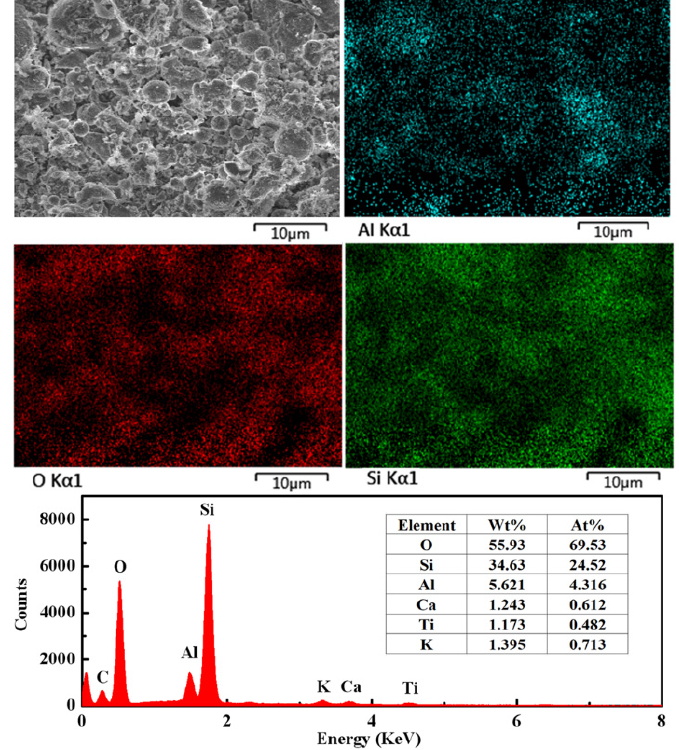
Figure 13. SEM and EDS images of residue.